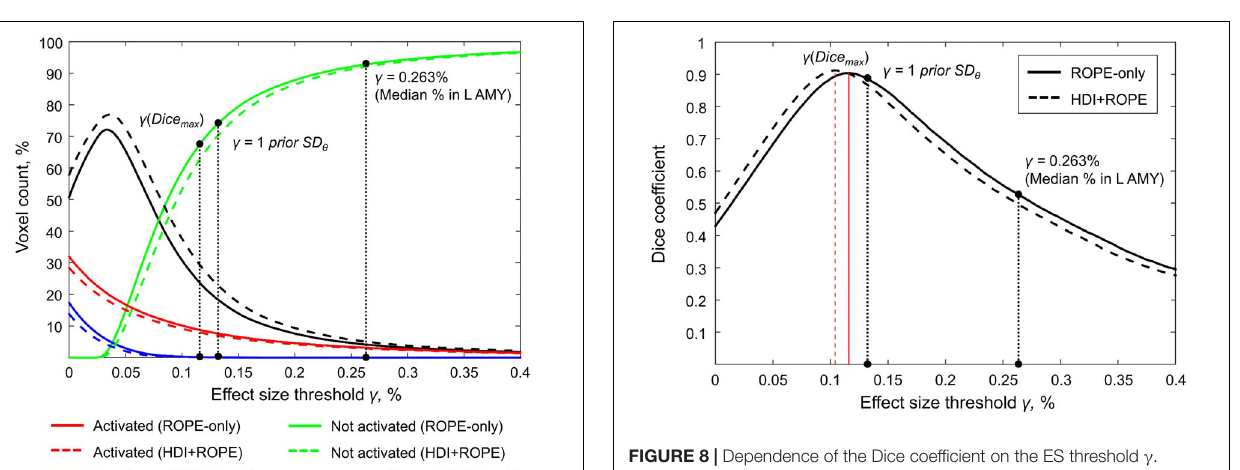
FIGURE 8 | Dependence of the Dice coefficient on the ES threshold γ . Results for the emotion processing task (‘Emotion > Shape’ contrast). The red lines denote γ (Dice max ) . L AMY, left amygdala. example, for the ‘2-back > 0-back’ contrast, the median PSC in the right dorsolateral prefrontal cortex (R DLPFC in Figure 9 ) was 0.137%. Likewise, for the ‘Social > Random’ contrast, the right inferior parietal lobule (R IPL) median PSC was 0.137%, for the ‘Correct Stop > Go,’ the right